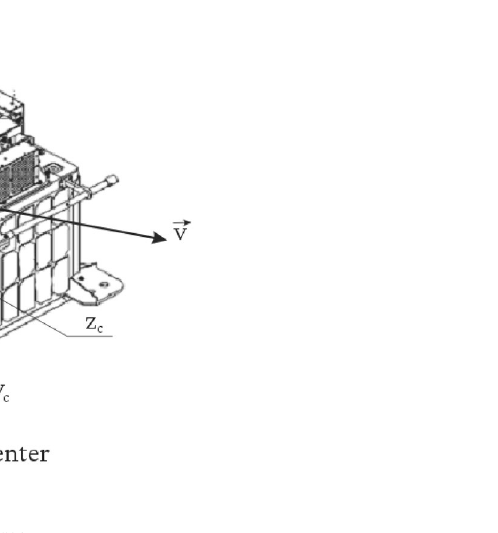
Figure 3. There are used coordinate